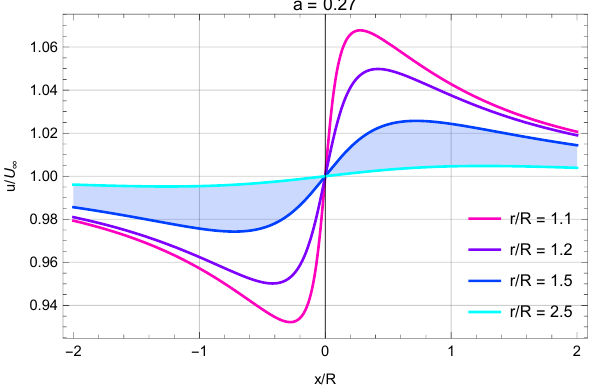
Figure 3. Solution of the actuator disk model by Conway (1995) for an induction factor of a = 0 . 27 and different ratios of the distance to the centre line r divided by the radius of the disk R . The shaded sector indicates the range in which the inflow measurement volume is